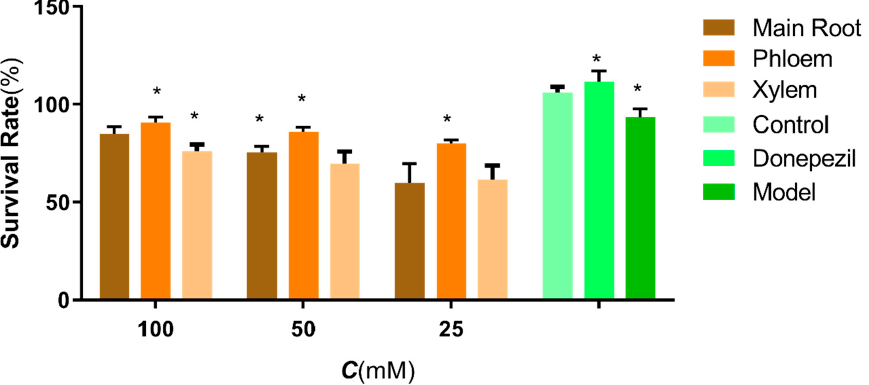
Figure 1. Effects of the different parts in ginseng on H 2 O 2 damage to SH-SY5Y cells. The data are presented as the means ± SEM (n = 3). *: p < 0.05 compared with the model group.